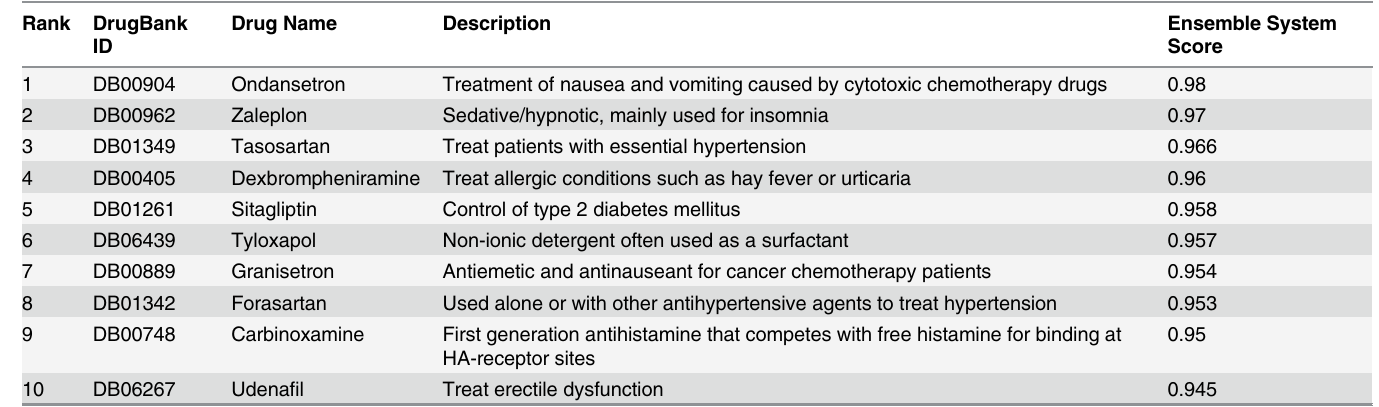
Table 4. Top 10 ranked predictions by DRAMOTE for BioAssay 938 with TSHR protein target. Rank DrugBank